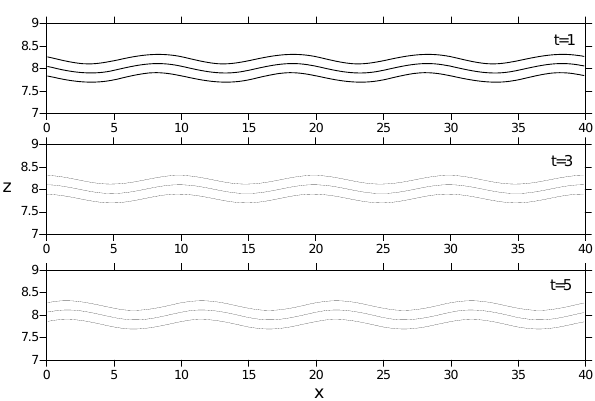
Fig. 2b. The instantaneous contours of the density deviation obtained in the central ( x,z )-plane at different time moments in DNS with initial condition (3.2) prescribed for IW, propagating from left to right with wavelength λ = 10 (frequency ω = 0.489, phase velocity c ≈ 0.78). The turbulence forcing is off. Density contours are 1.3, 1.5, 1.7. Contour 1.5 marks the position of the pycnocline center.